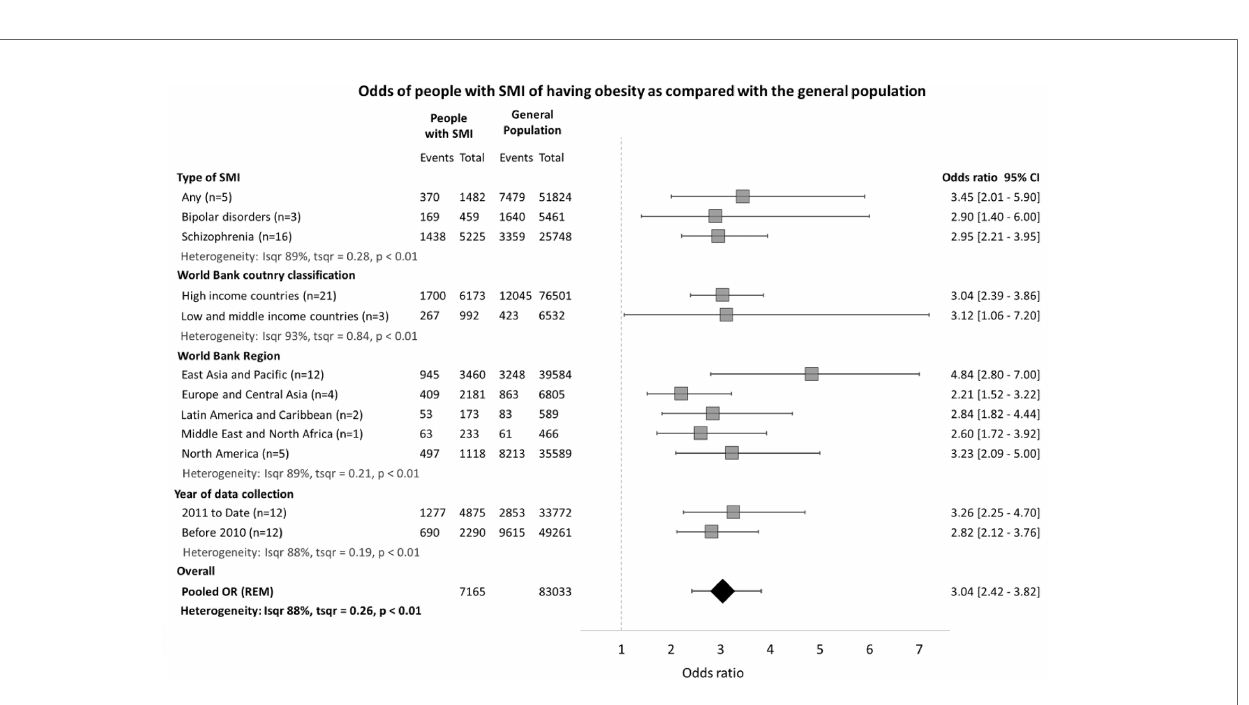
FIGURE 5 | Odds of people with SMI of having obesity as compared to the general